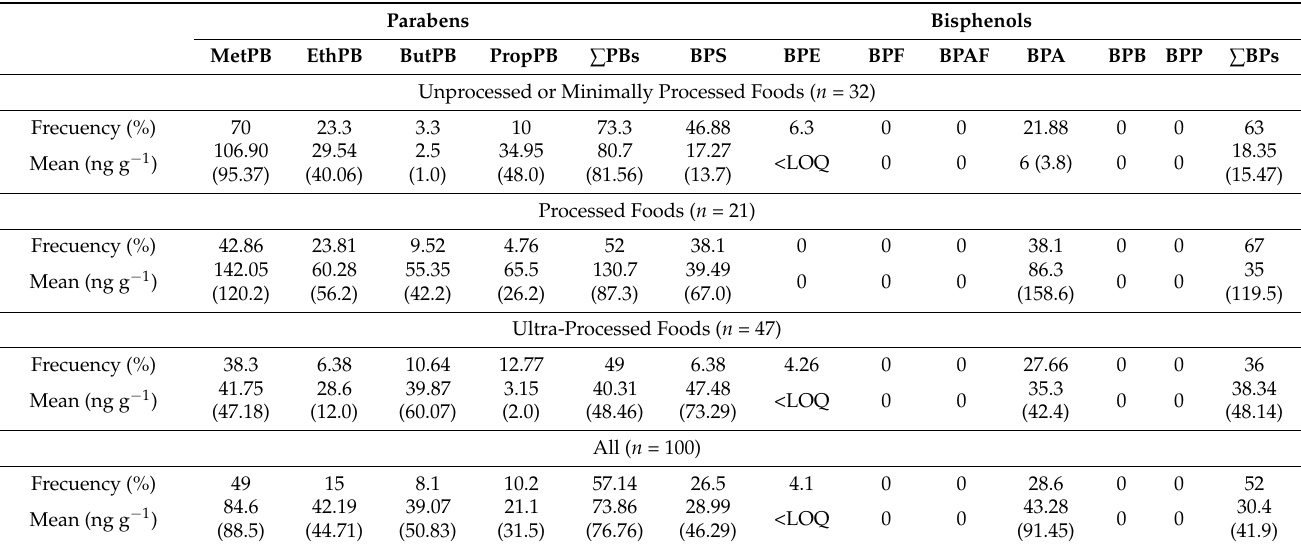
Table 3. Frequencies (%) and mean (ng g − 1 ) of parabens and bisphenols in food samples. Parabens Bisphenols MetPB